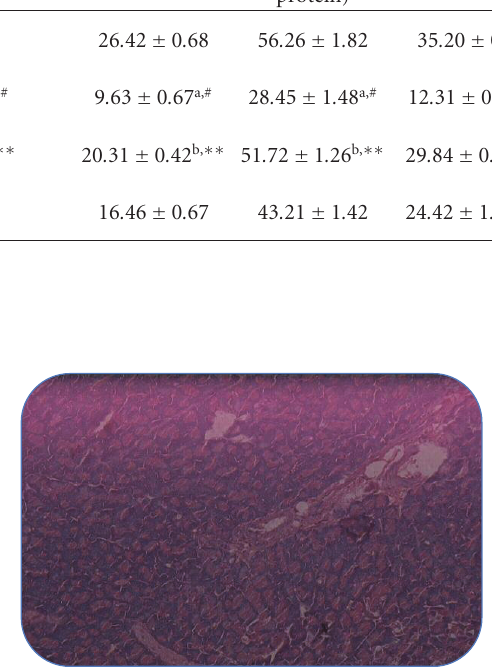
Figure 1: Pancreatic section of normal rat stained with haemo- toxylin and eosin.